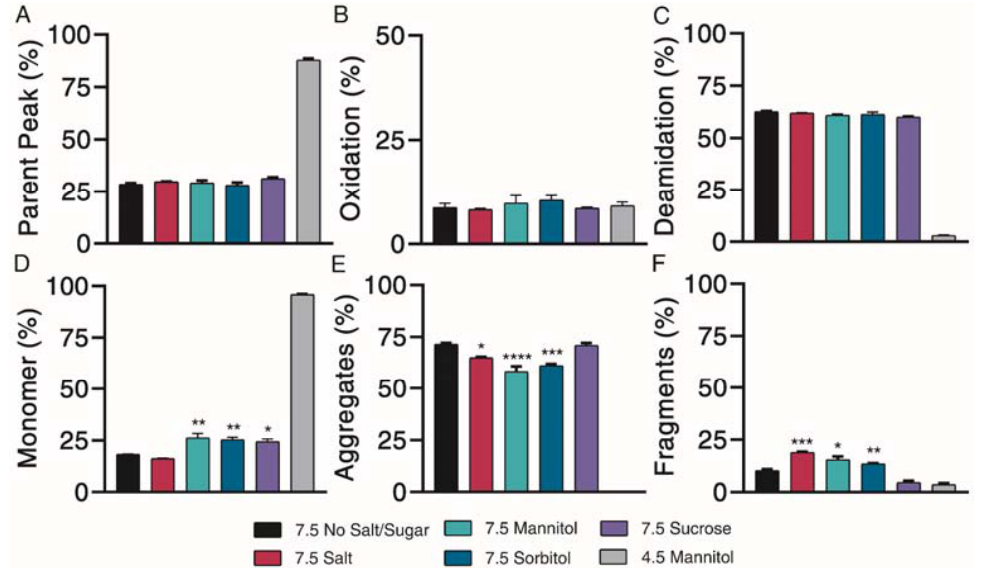
Figure 5. Kinetics of degradation determined by reverse-phase and size exclusion chromatography, with reverse-phase liquid chromatography separating ( A ) parent peak from ( B ) oxidation and ( C ) deamidation chemical impurities and size exclusion chromatography separating ( D ) monomer from ( E ) aggregate and ( F ) fragment physical impurities of exenatide reconstituted at pH 4.5 with mannitol and pH 7.5 with specified excipients after incubation at 37 °C for 4 weeks. ( n = 3, mean ± SEM, * p < 0.05 ** p < 0.01 *** p < 0.001 **** p < 0.0001). Table 2. Particle size distribution determined by dynamic light scattering (by volume) and separated into 0.3–10, 10–100, 100–500, 500–1000 and 1000+ nm size ranges for exenatide that was reconstituted at pH 4.5 with mannitol and pH 7.5 with specified excipients when incubated at 37 ◦ C after weeks; ( n = 3,